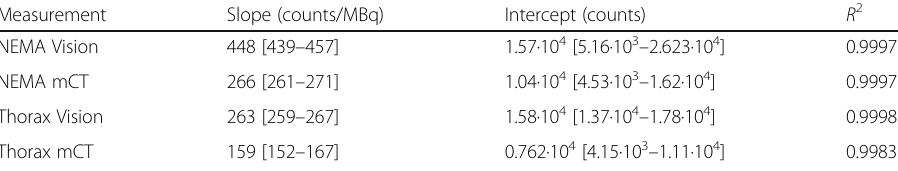
Table 3 Slope, intercept, and coefficient of determination ( R 2 ) of the linear fit of the net true counts in the sinograms. Numbers between brackets are the 95% confidence intervals Measurement Slope